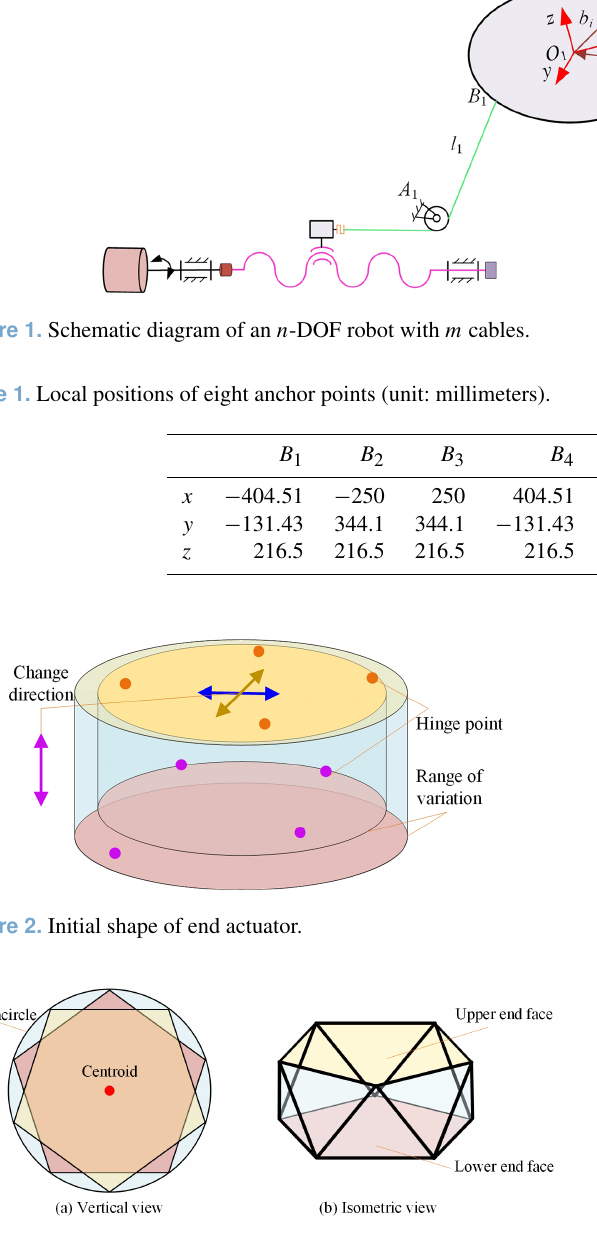
Figure 3. Optimized structure of end